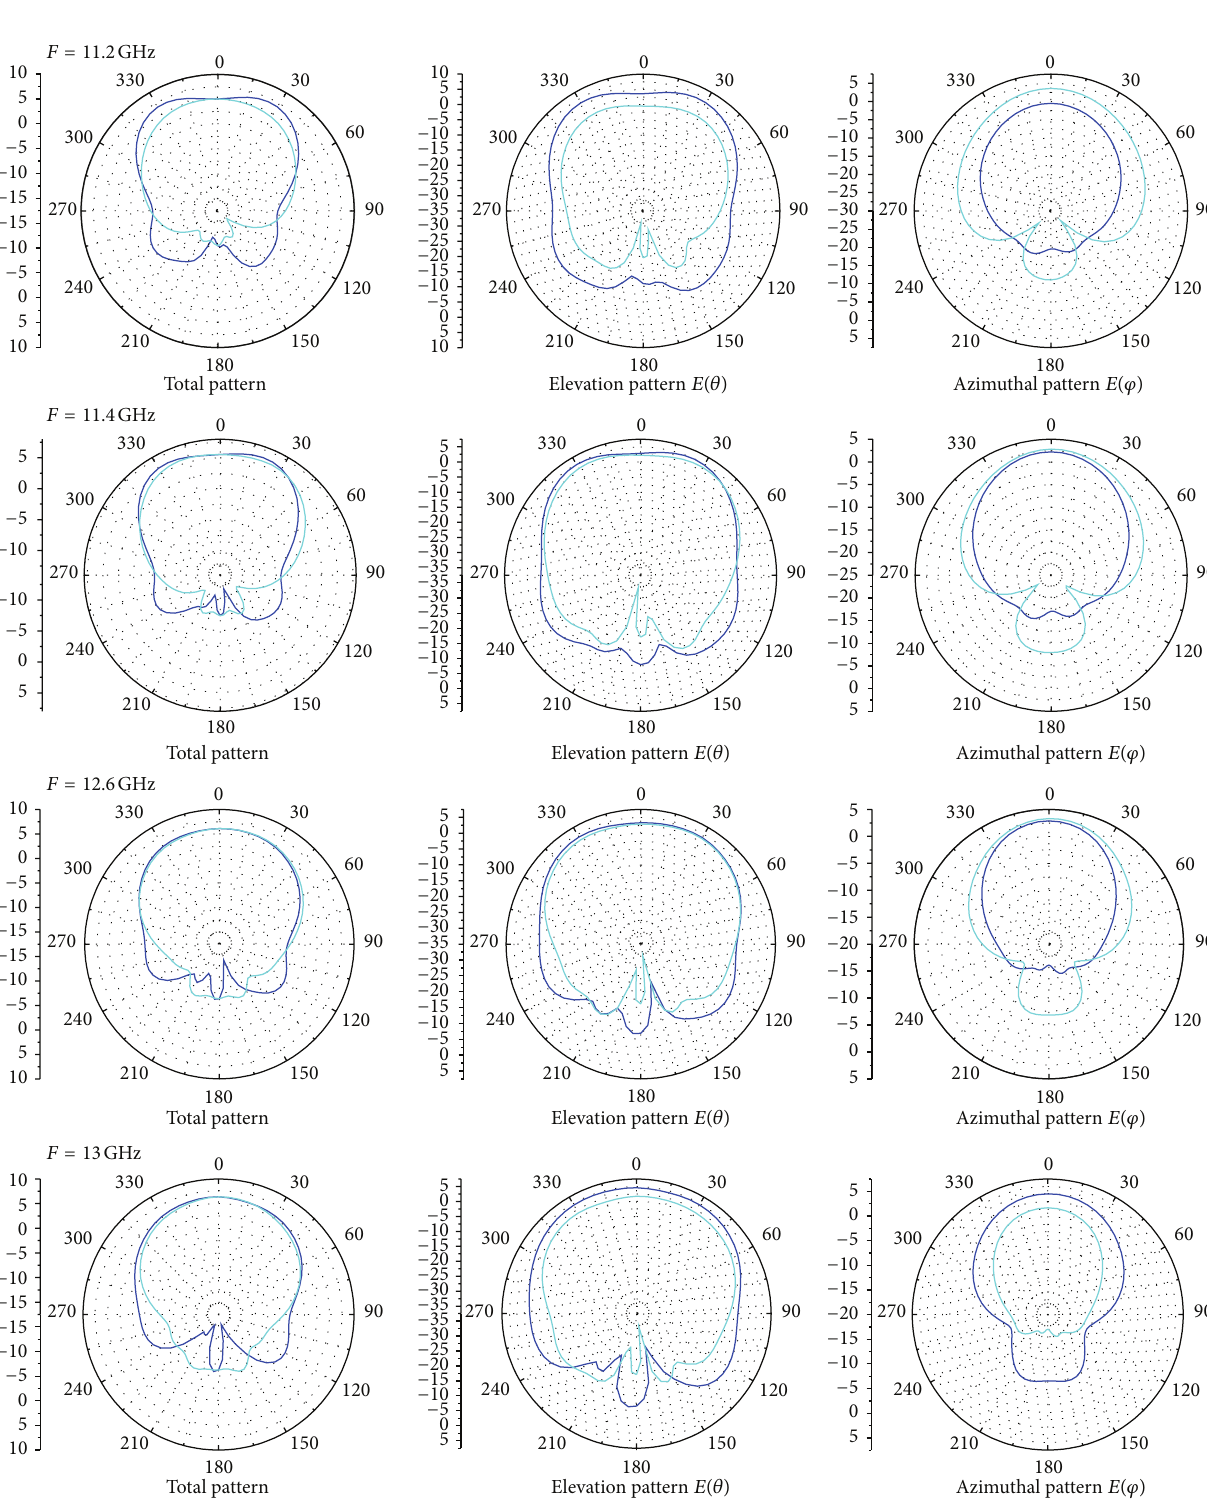
Figure 7: 2D radiation patterns of aperture coupled microstrip patch antenna by using inverted